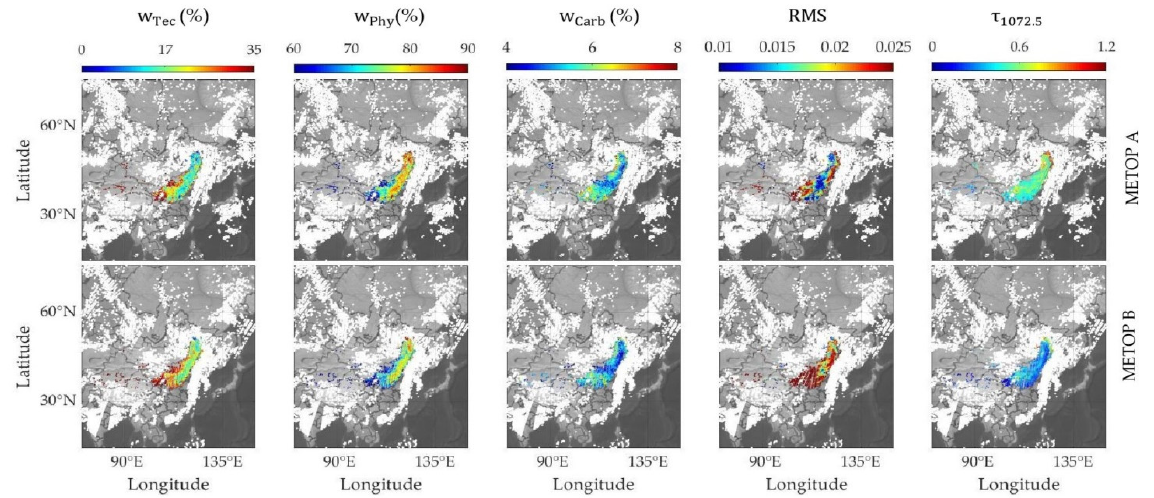
Figure 16. Mineralogical extinction coefficient maps of tectosilicates, phyllosilicates, and carbonates on May 4 during the 2017 dust storm from IASI detection of METOP-A and